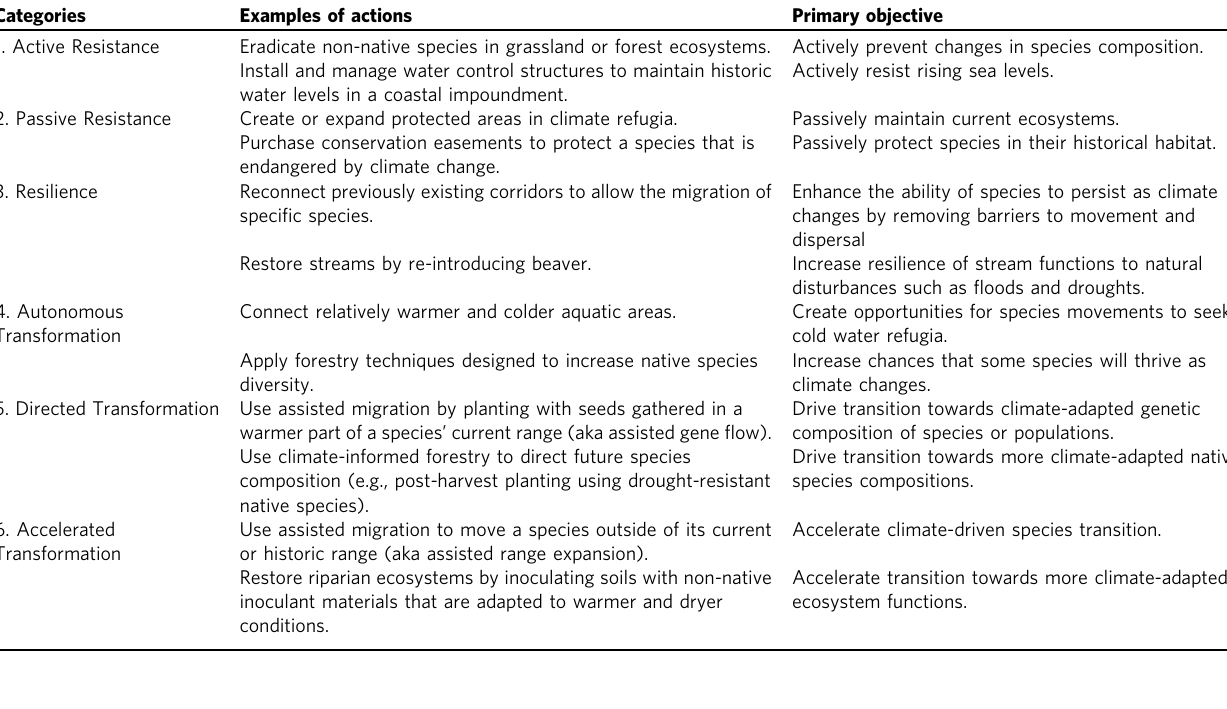
Table 1 Examples of adaptation actions and their primary objective for the six categories of the “ R – R – T scale ” . Categories